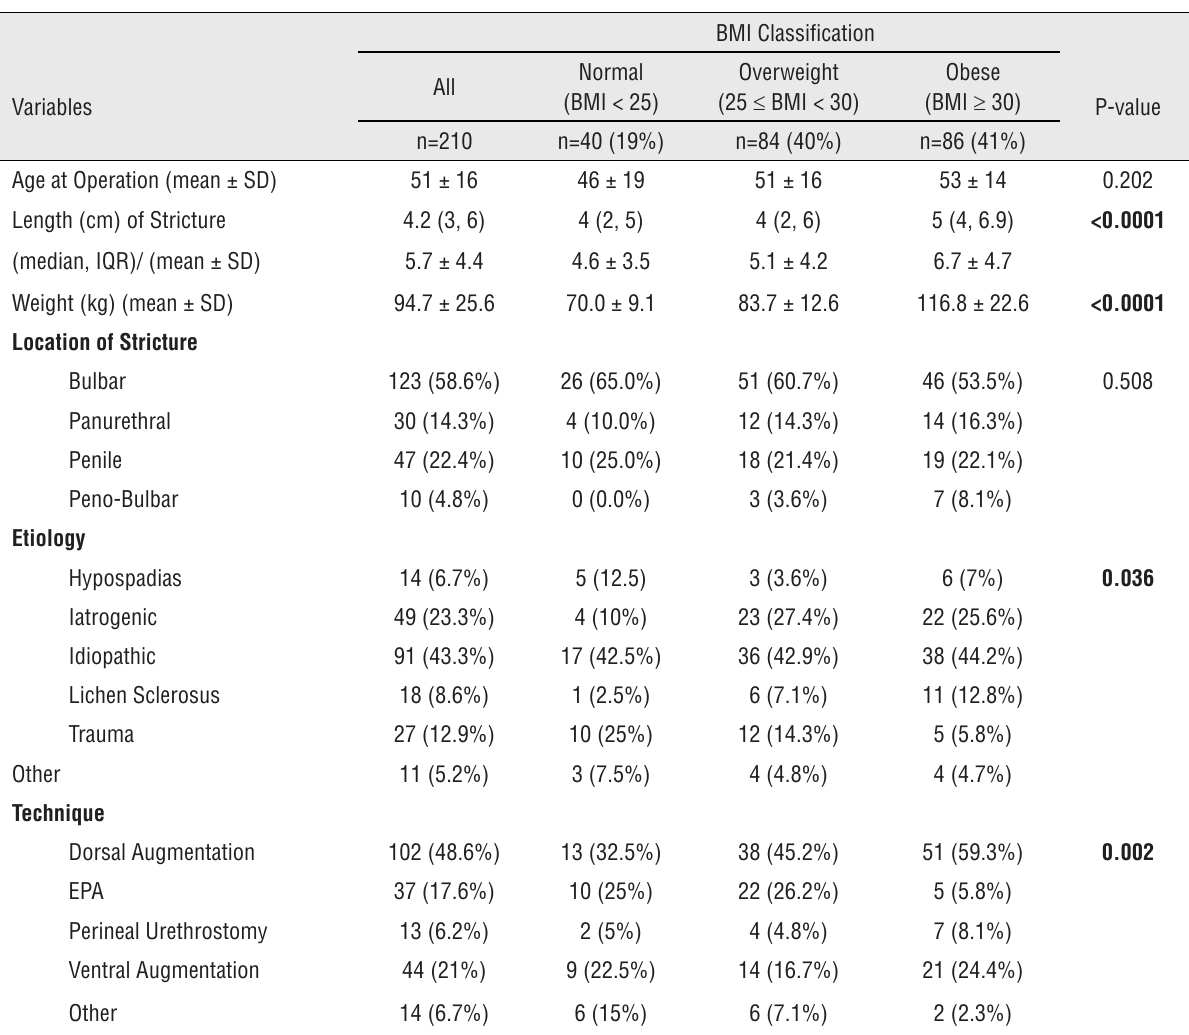
Table 1 - Patient characteristics by BMI